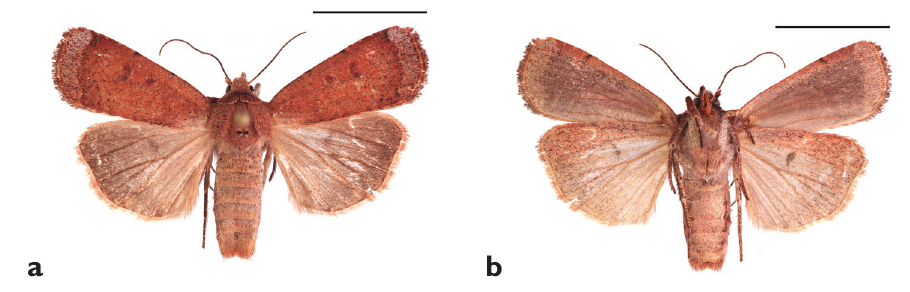
Figure 17. Abagrotis benjamini Franclemont, Aquinnah, MA. P.Z. Goldstein. a Dorsal b Ventral. Scale bars: 1 cm (Photos B. Proshek).